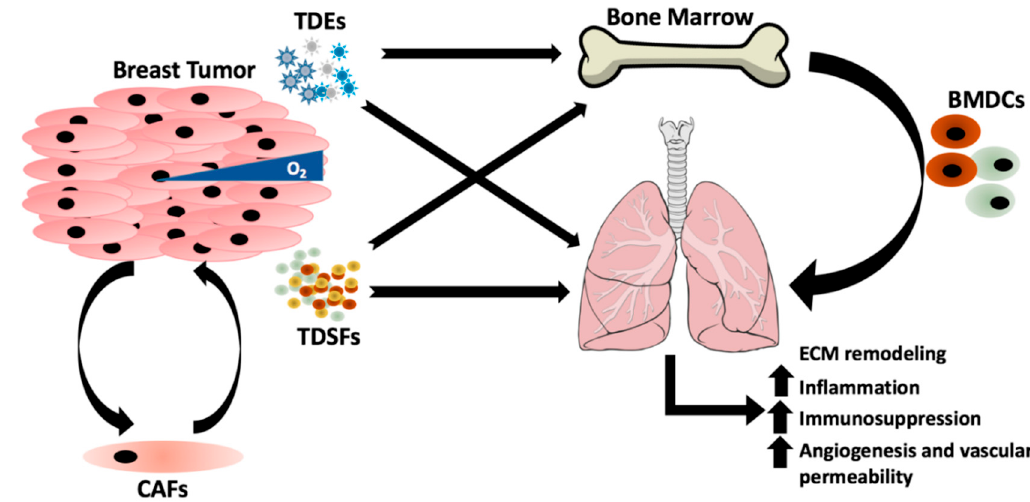
Figure 1. The underlying mechanisms that dictate the organ colonized by breast cancer are complex and influenced by many factors. Breast primary tumors regulate and prime the lung for metastasis by the secretion of tumor-derived exosomes (TDEs) and tumor-derived secreted factors (TDSFs), which target the bone marrow for recruitment of bone marrow-derived cells (BMDCs) to lung in order to induce changes in the extracellular matrix (ECM) that are conducive for metastasis. Release of TDSFs from the primary tumor are often regulated by stromal cells that compose the tumor microenvironment including cancer associated fibroblasts (CAFs) or environmental stimuli such as hypoxia.